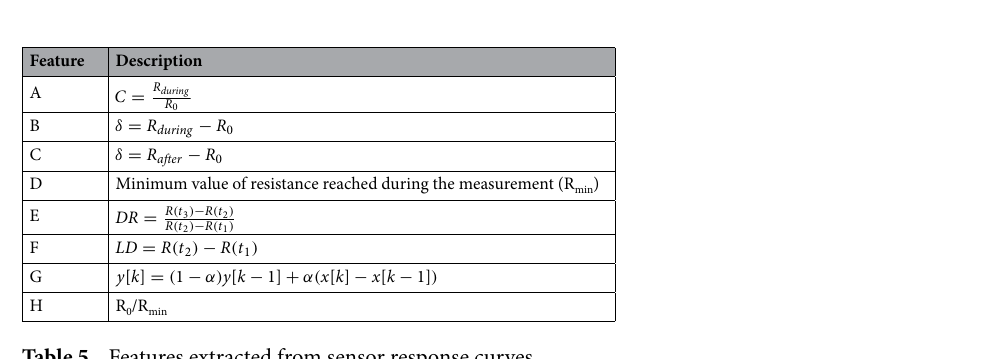
Table 5. Features extracted from sensor response